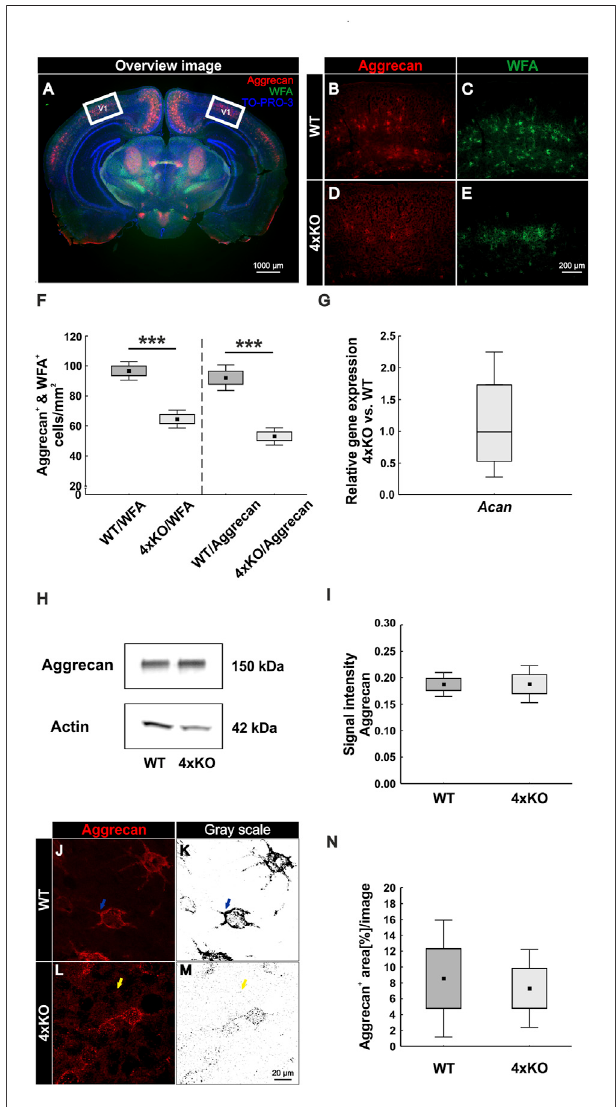
FIGURE 1 | Diminished PNN organization in the visual cortex of quadruple knockout mice. (A – E) Immunohistochemical staining of PNNs in